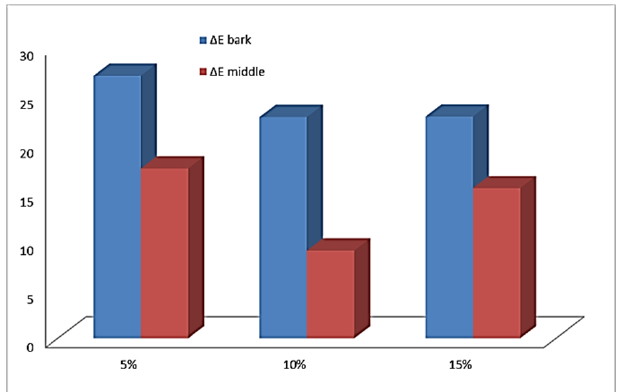
Figure 2. Color indicators of crumb cake elderberry blossom flour ( Sambucus nigra L.).